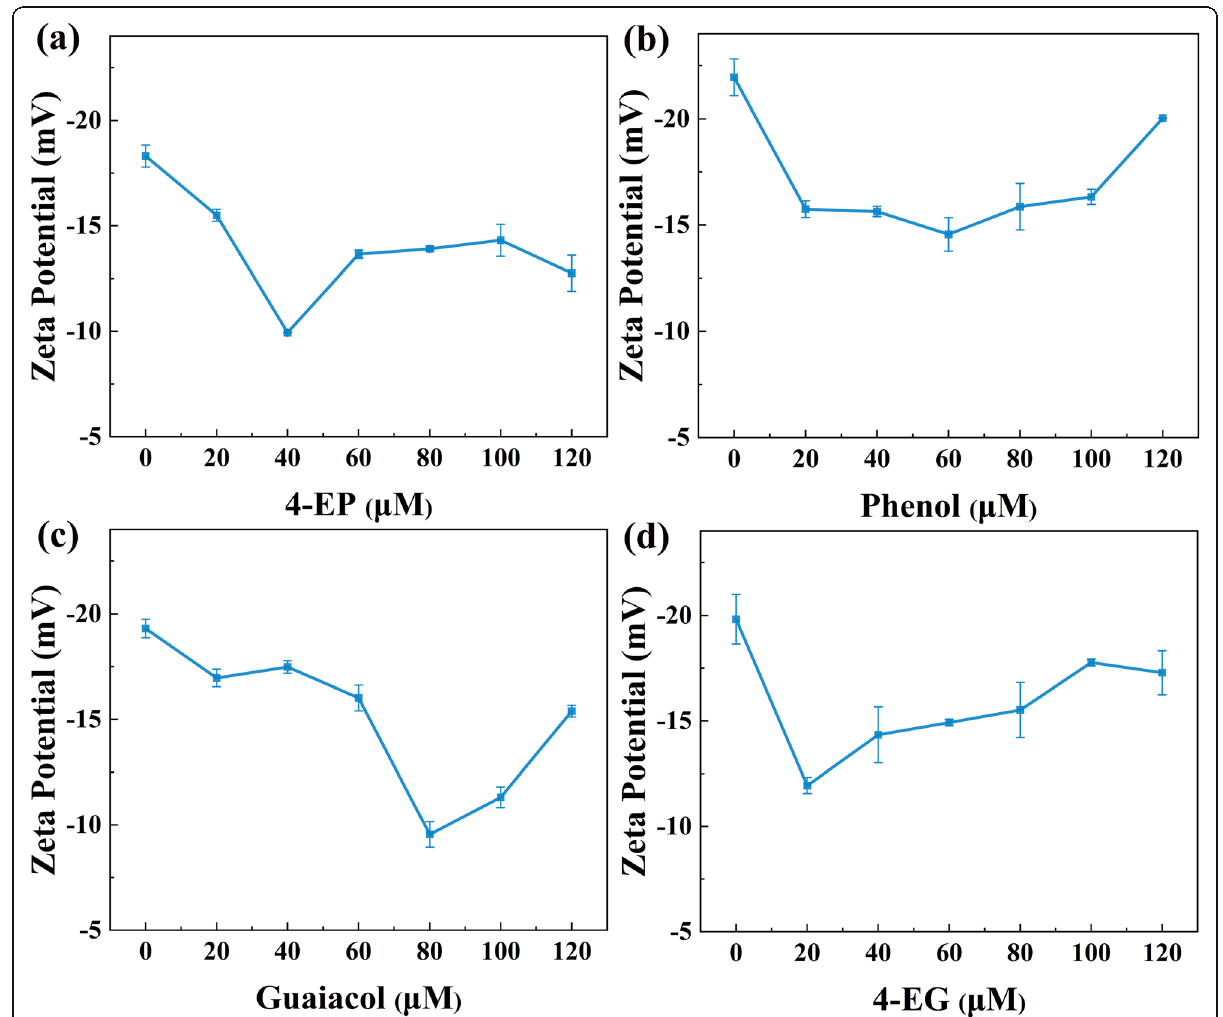
Fig. 2 Zeta potential changes in Collagen peptides in the presence of different concentrations of 4-EP ( a ), phenol ( b ), guaiacol ( c ), and 4-EG ( d